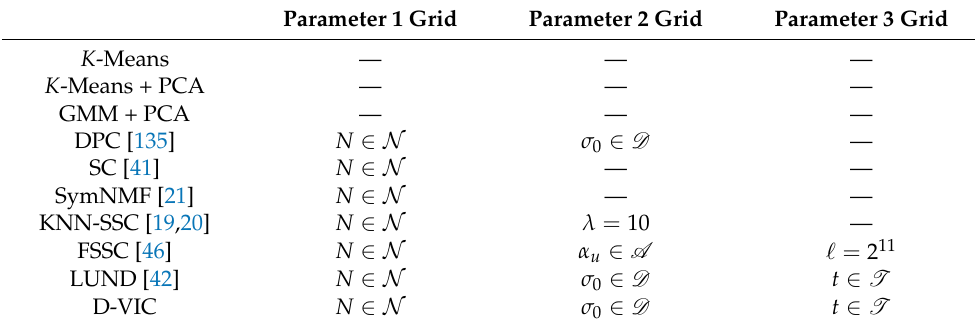
Table A1. Hyperparameter grids for algorithms. The number of nearest neighbors N took values in N : an exponential sampling of the set [ 10,900 ] . The set A is a grid of values ranging from 0 to 1 used as FSSC regularization parameters. The set D contains (cid:96) 2 -distances between data points and their 1000 (cid:96) 2 -nearest neighbors. The set T is an exponential sampling of the diffusion process: T = { 0,1,2, . . . ,2 2 , . . . ,2 T } . A “—” indicates a lack of a hyperparameter input. Parameter 1 Grid Parameter 2 Grid Parameter 3